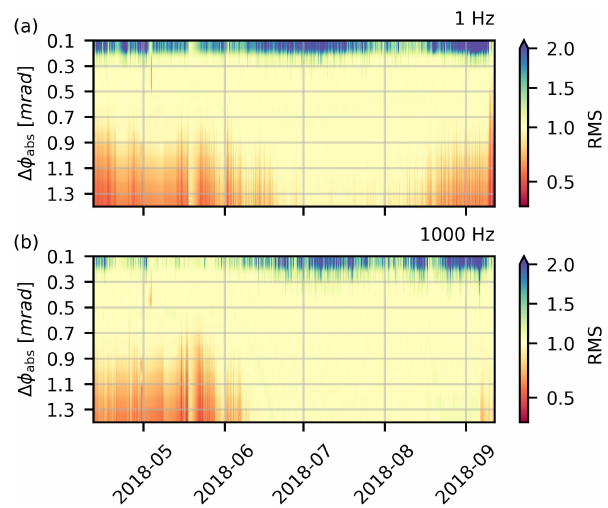
Figure 12. Normalised rms error for the phase for the final iter- ation throughout the growing season 2018 for (a) 1Hz and (b) 1kHz for different levels of absolute phase measurement error (cid:49)φ . Please note that the normalised rms values for the magnitude are not